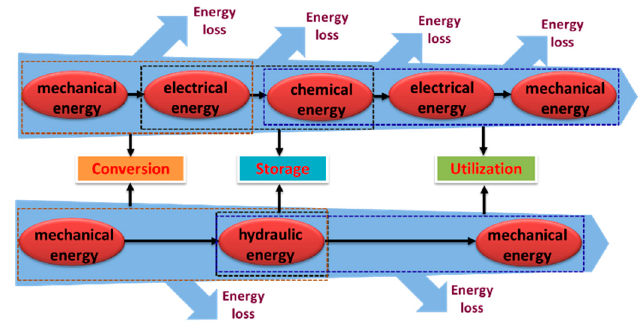
Figure 12. Schematic of energy flow in different energy harvesting systems.